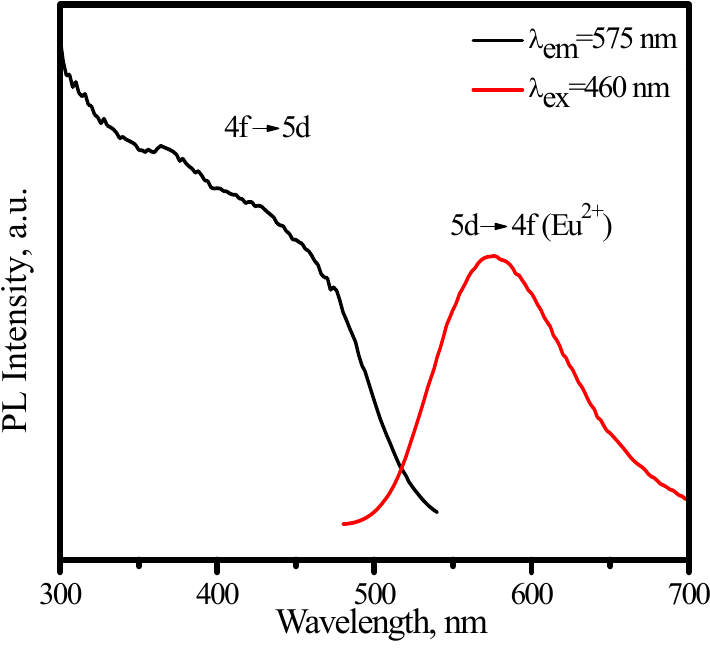
Ba Eu )SiO under 460 nm excitation measured at 1.7 0.2 0.1 4